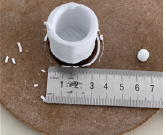
Figure 2. Extrusion-based mold printing of alumina ceramics: ( a ) 30 layers of high-hollow pure alumina body; ( b ) alumina green body with carbon fiber added; ( c ) solid pure alumina green bodies with different shapes.